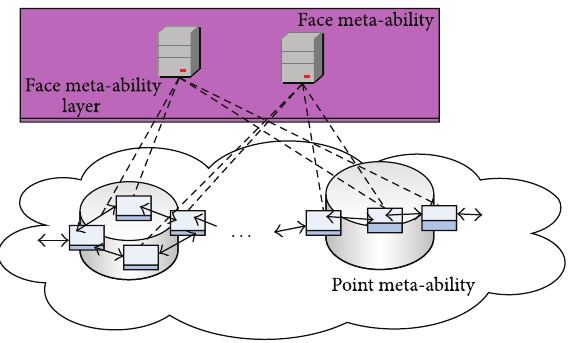
Figure 2: The reconfiguration mechanism of face metaability.